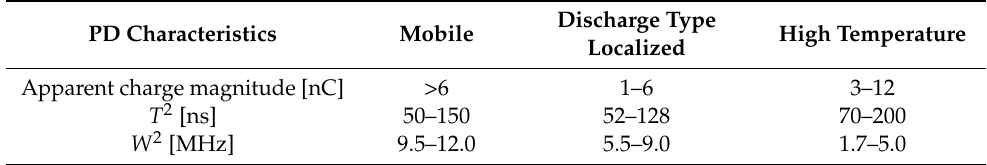
Table 2. Positive DC partial discharge